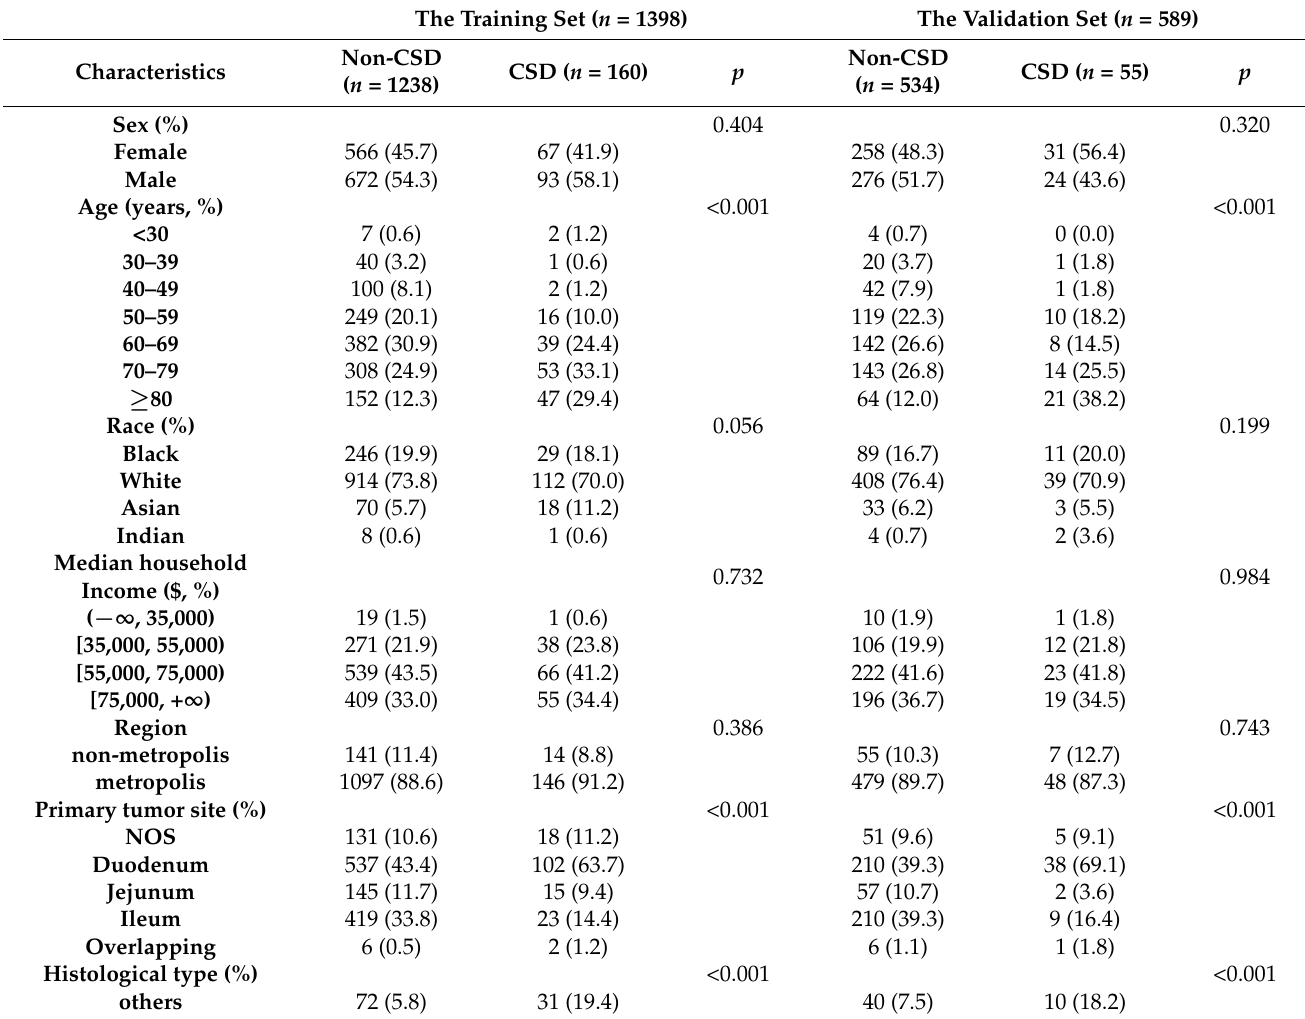
Table 1. Characteristics of patients included in our